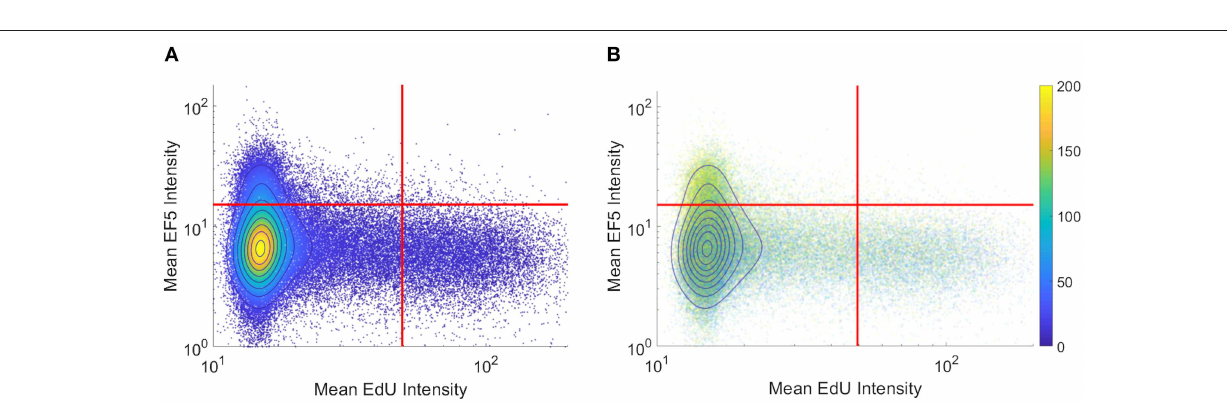
FIGURE 3 | Per-cell scatterplot of hypoxia marker (EF5, vertical axis) vs. proliferation marker (EdU, horizontal axis). Regions of increasing density are shown with contour lines in both images. (A) density is also represented in color, while in (B) individual cells are colored by their individual distances to the blood vessel regions (distances, in microns, shown on